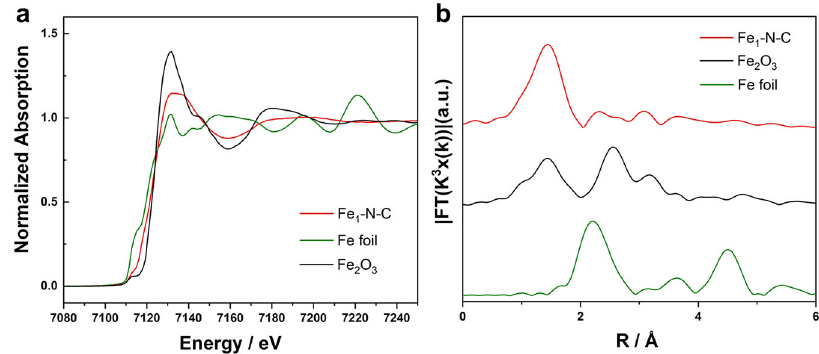
Fig. 4 Structural characterizations of Fe 1 -N-C. a XANES spectra and b FT EXAFS spectra of Fe foil, Fe 2 O 3 , and Fe 1 -N-C at the Fe K-edge.